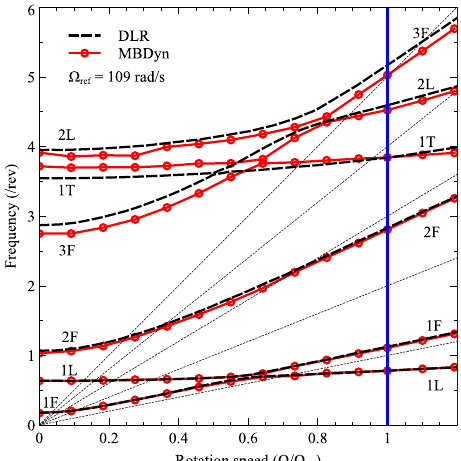
Figure 15. HART II rotor blade frequencies.